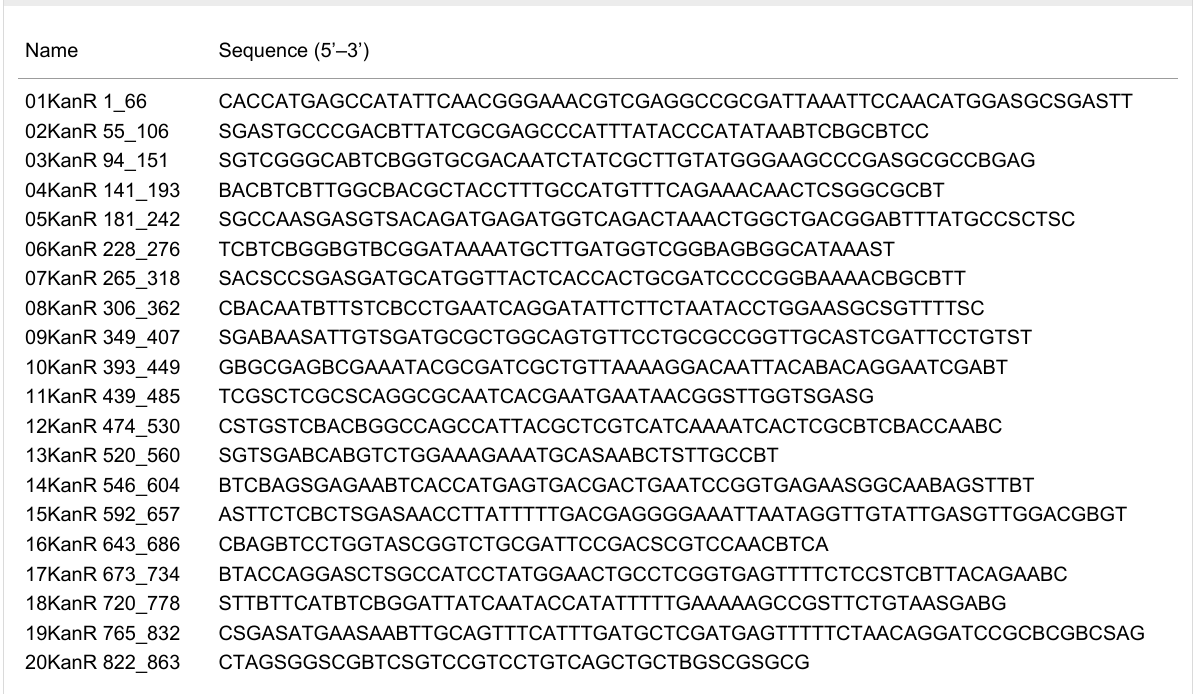
Table 1: Oligonucleotides containing S (2’-deoxy-5-methylisocytidine) and B (2’-deoxyisoguanosine) used in this